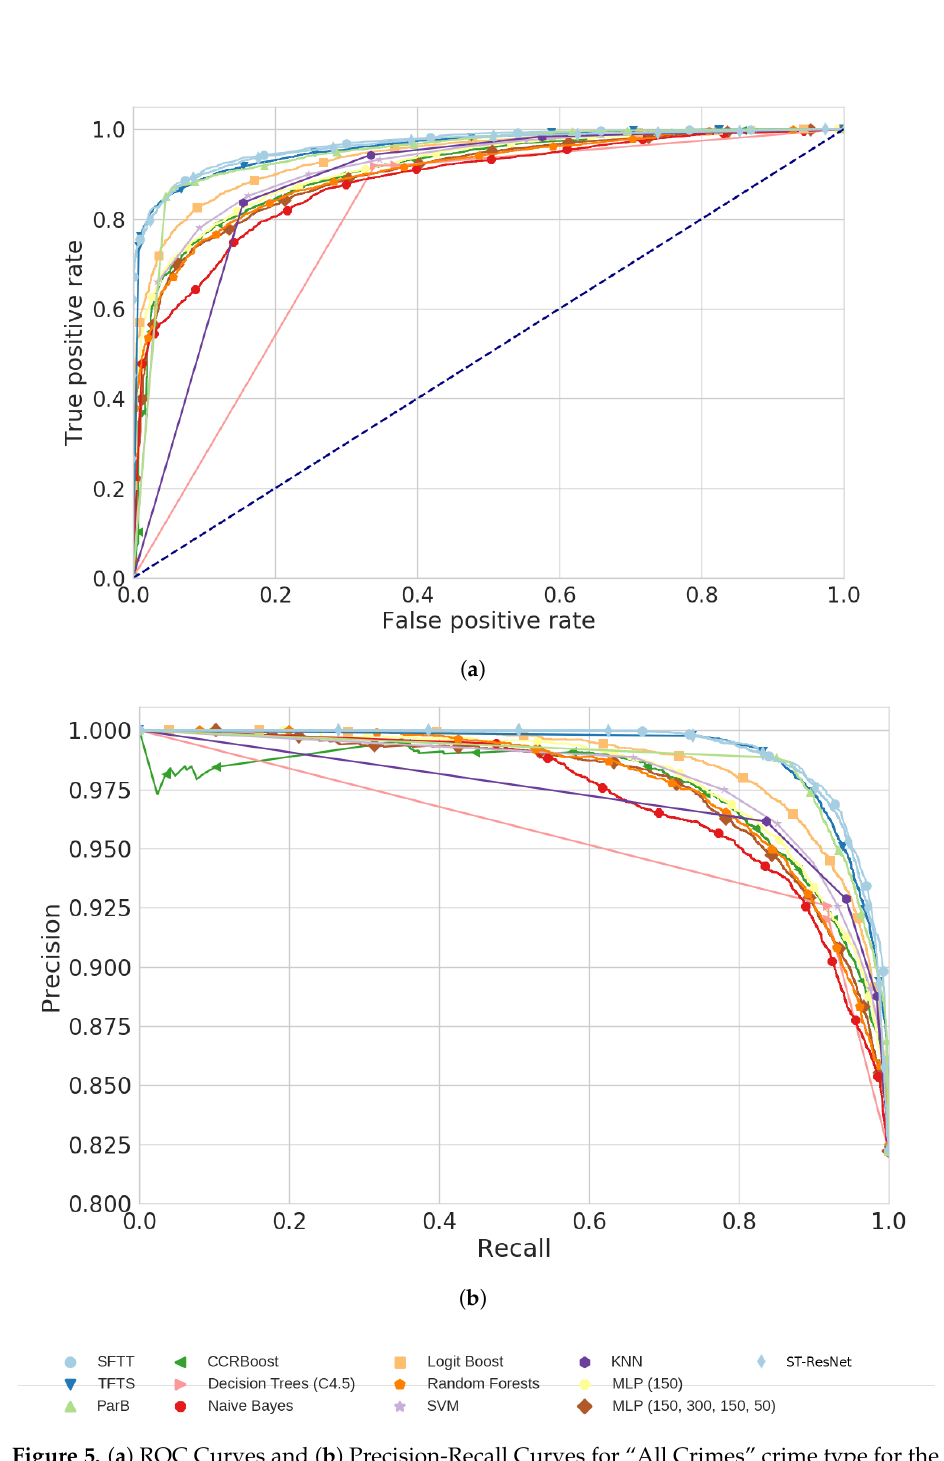
Figure 5. ( a ) ROC Curves and ( b ) Precision-Recall Curves for “All Crimes” crime type for the 4 DL bodies and 10 baseline approaches in the Philadelphia dataset. Best viewed in